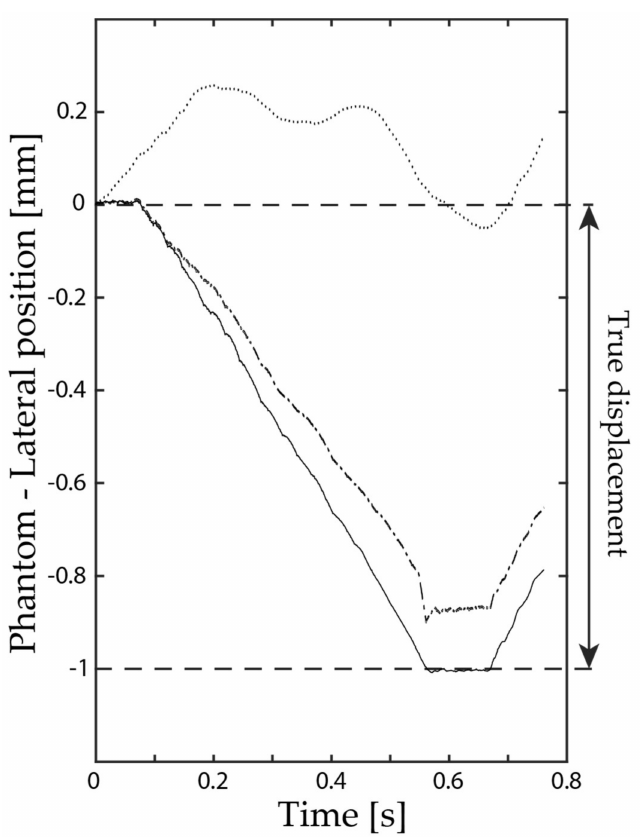
Figure 3. The lateral position of a kernel estimated by the proposed iterative tracking scheme with an initial length of iteration set to k = 128 (solid line), k = 16 (dash-dotted line), and k = 1 (dotted line). The 100 µ m pitch transducer was displaced 1 mm laterally relative to the phantom with a lateral velocity of 2 mm/s while sampling 1302 frames per